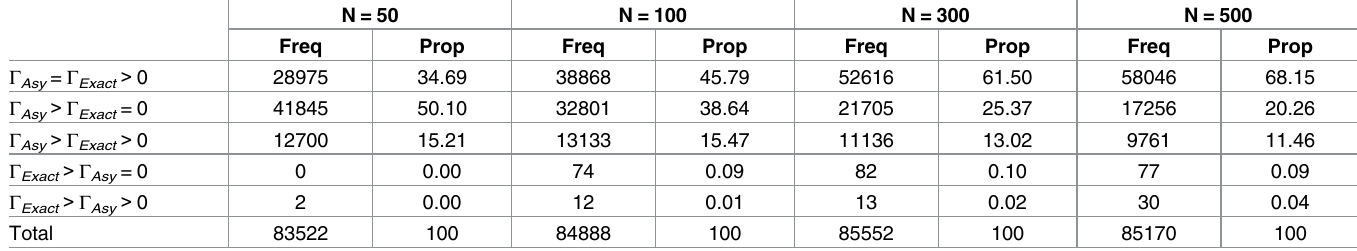
Table 6. For a 3 × 3 contingency table, frequency (Freq) and proportion (Prop) of simulated data having at least one cell is significant based on either T AdjR or exact p-value, from a total of 2 million simulations. Γ Asy and Γ Exact are the numberof cells with significantp-valuesby using the asymptotic approachand the exact